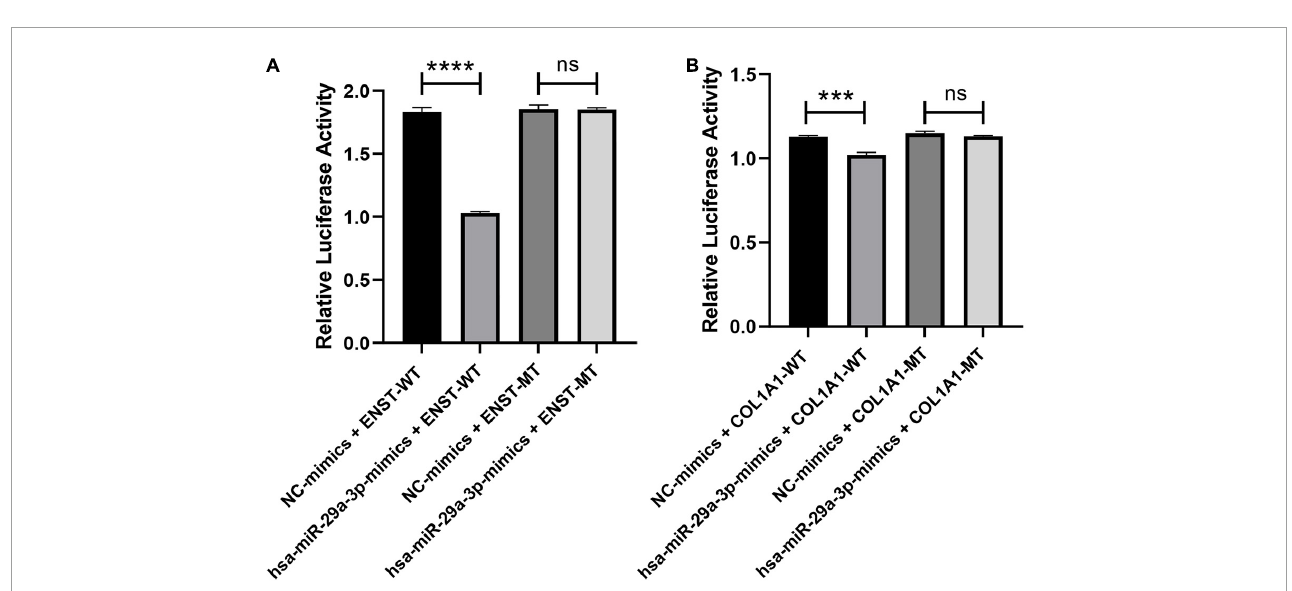
FIGURE14 Verification of the ENST00000313807-hsa-miR-29a-3p- COL1A1 interaction by a double-luciferase reporter gene assay. (A) The WT or mutation reporter plasmid of ENST00000313807 was co-transfected with the hsa-miR-29a-3p mimic or negative control (NC) mimic into 293T cells. (B) The WT or mutation reporter plasmid of COL1A1 was co-transfected with the hsa-miR-29a-3p mimic or negative control (NC) mimic into 293T cells. **** P < 0.0001, *** P < 0.001. NC, negative control; WT, wild type; MT, mutant; ns, no significance.